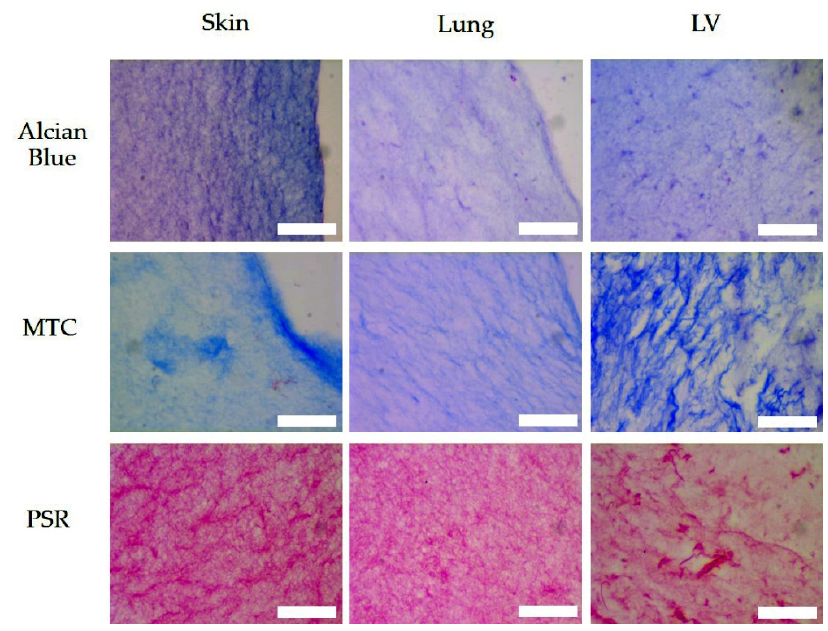
Figure 6. Alcian Blue, MTC and PSR, stains in sections of skin-ECM, lung-ECM and LV-ECM. Scale bars: 50 µm.